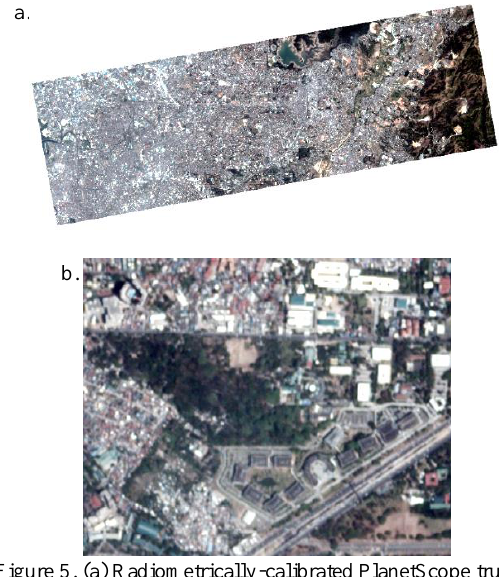
Figure 5. (a) Radiometrically-calibrated PlanetScope true- color image of a portion of Metro Manila acquired on 23 March 2019 and (b) Sample subset of the image which consists of general land cover classes (vegetation, soil, built- up)